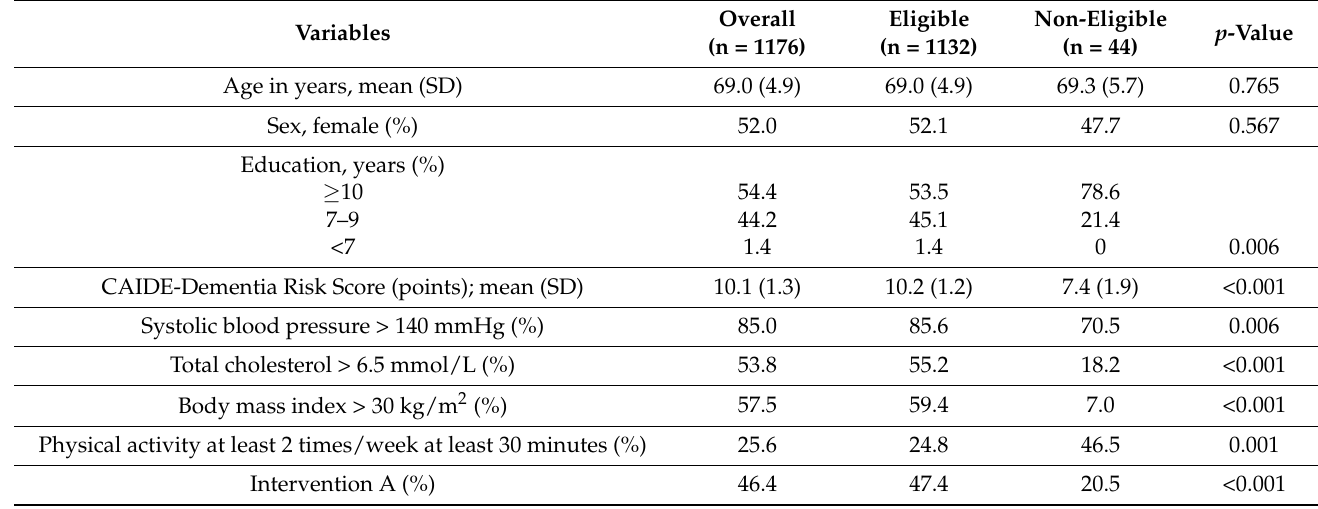
Table 1. Characteristics of eligible and non-eligible participants in the AgeWell.de trial.